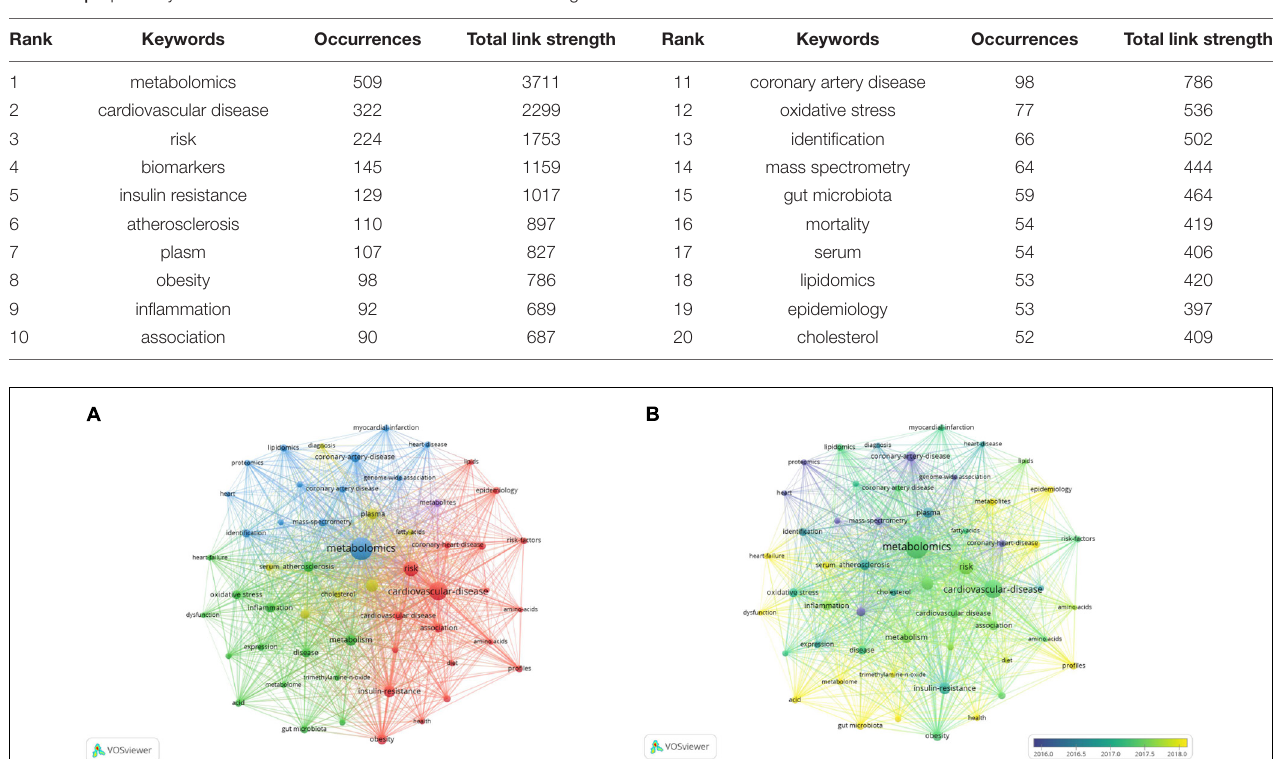
FIGURE 5 | Analysis of keywords in studies related to metabolomics and coronary artery disease. (A) VOSviewer visualisation map of co-occurring keywords. The node represents keywords, and a larger size represents the keyword that appeared at a higher frequency. The thickness of the lines indicates the strength of the relationship. The colours of nodes are used to indicate different clusters. (B) VOSviewer overlay visualisation map of co-occurring keywords. The colour of the node indicates the time when the topic word appears, and the emergence time of each keyword is the average value of the project in which it was